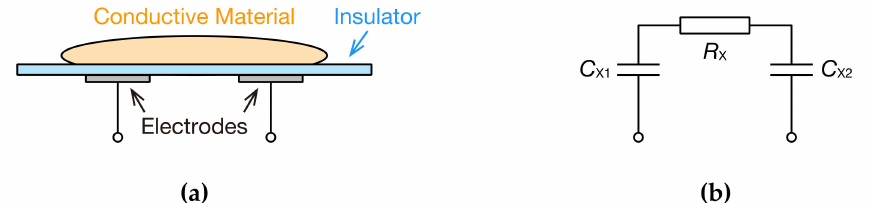
Figure 1. Schematic model of electrodes capacitively coupled to a conductive material via a thin insulator: ( a ) cross-sectional diagram; ( b ) equivalent circuit.